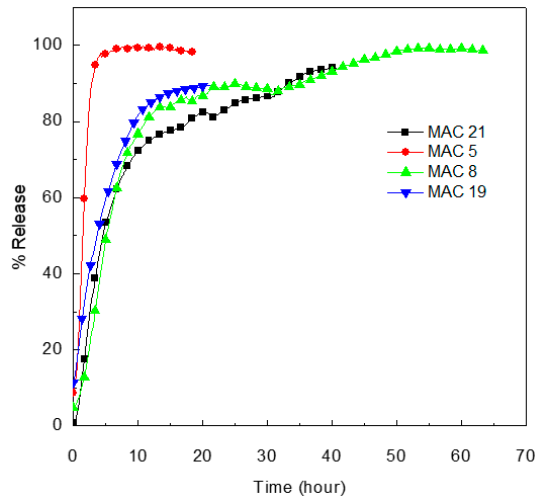
Figure 16. In vitrorelease behaviors of MET from MET-CS-AlgNPs nanocomposites in the 0.1 M HCl 434 solutions. 435 Table 7. The correlation coefficients ( R 2 ) obtained by fitting the MET release data from MET-CS- 436